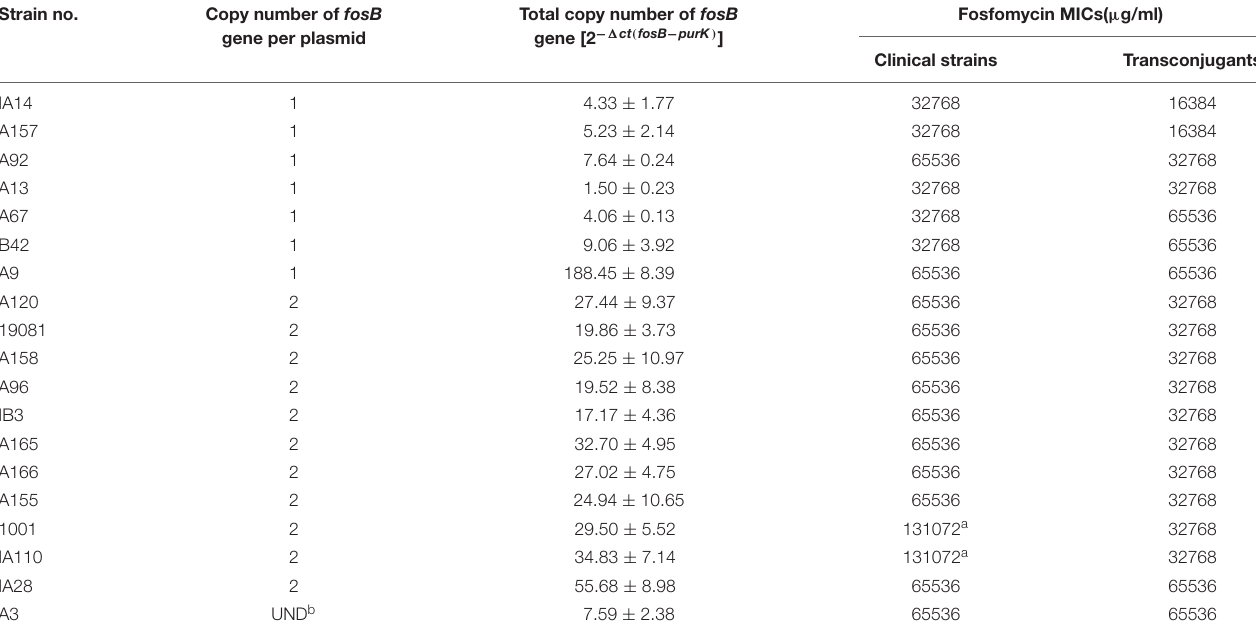
TABLE 1 | The fosB copy number and fosfomycin MICs without limitation of 19 vancomycin-resistant enterococci isolates. Strain